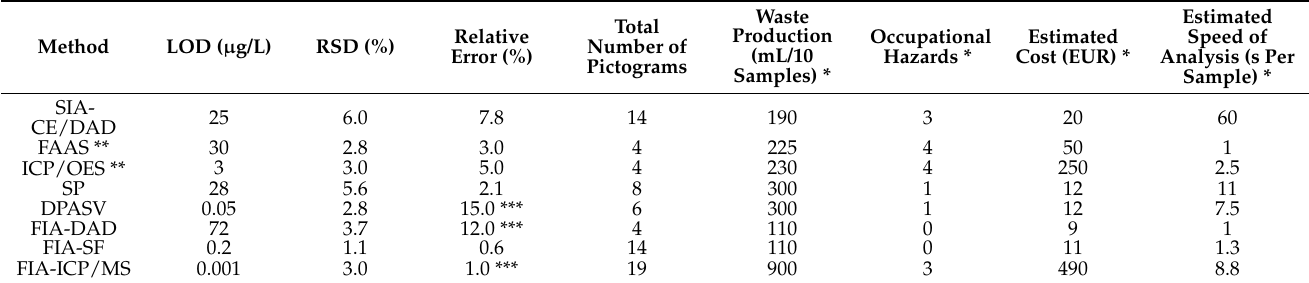
Table 2. Values of the key parameters used in the evaluation (taken from the literature or